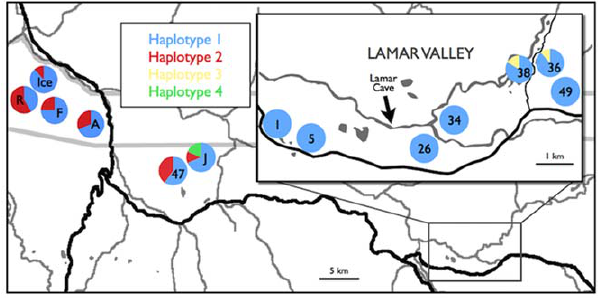
Figure 1. Map of field site with approximate locations of sampled ponds and proportion of individuals at each site that possessed each haplotype. Map area shows the Lamar Valley in northern Yellowstone National Park in Wyoming, USA. Thin grey lines show rivers, thick grey lines show park and state boundaries, black lines show roads. Lamar Cave site indicated with arrow. Samples collected from Lamar Cave=16 (all Haplotype 1), samples collected from Ice Lake (Ice)=17, Rainbow Lake (R)=12, Pond A=7, Pond F=12, Pond J=16, Pond 47=5, Pond 1=5, Pond 5=11, Pond 26=18, Pond 34=8, Pond 38=6, Pond 36=17, Pond